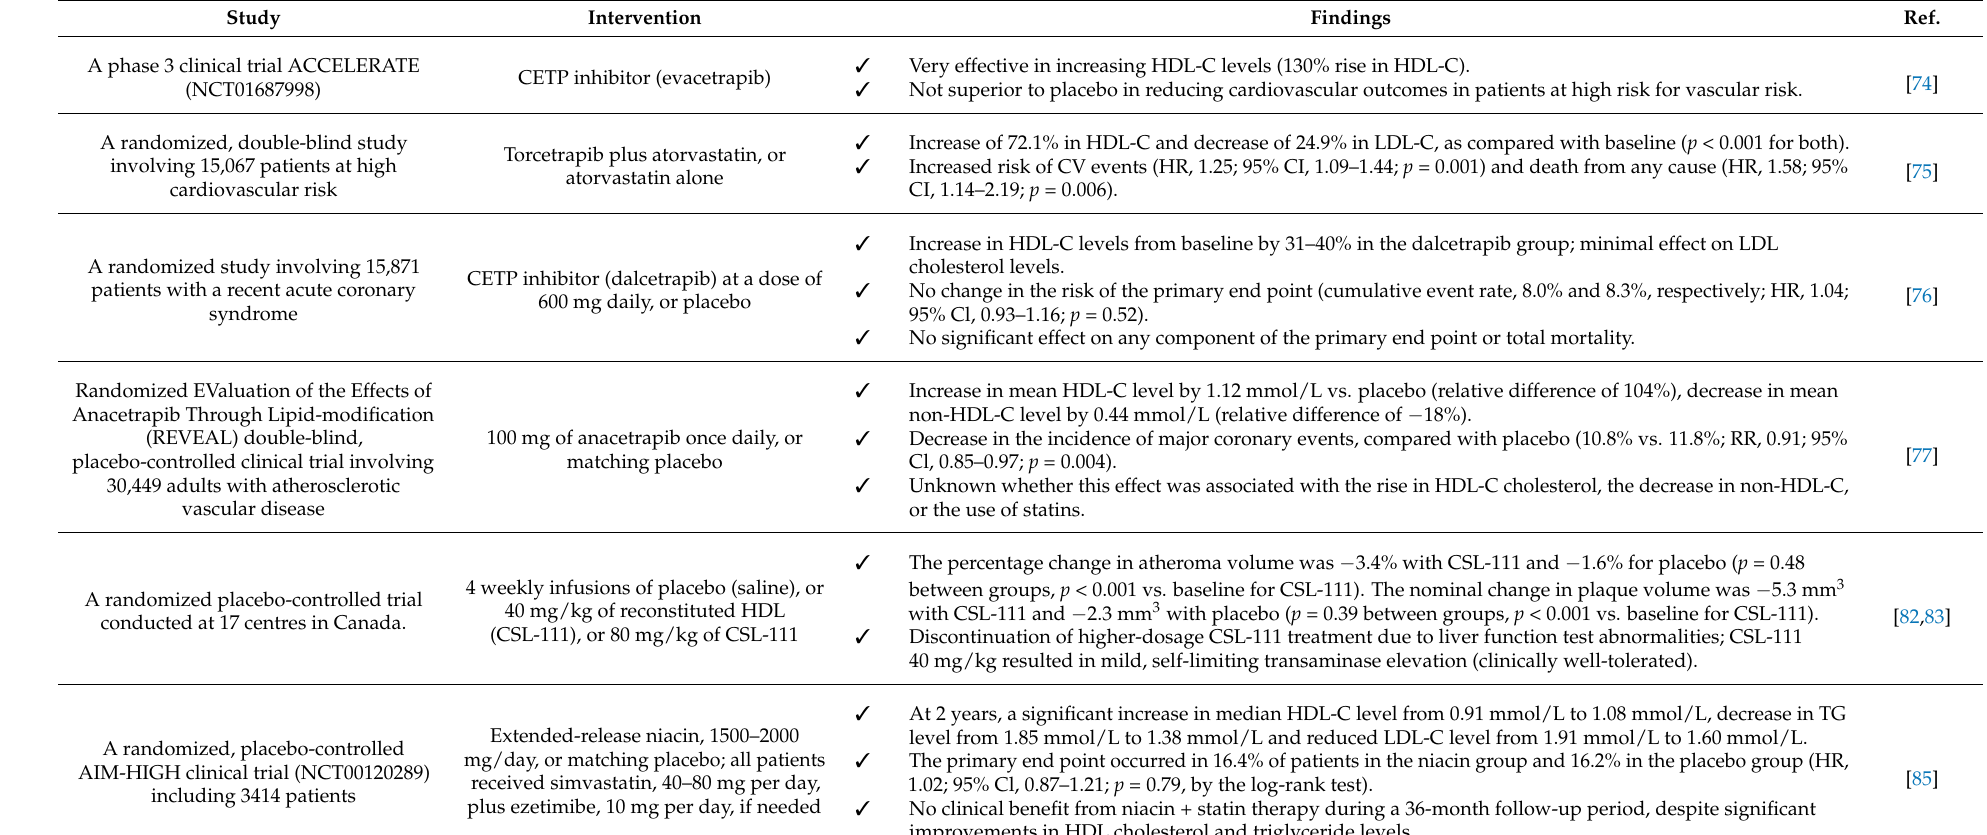
Table 2. Results of RCTs with drugs acting on HDL-C